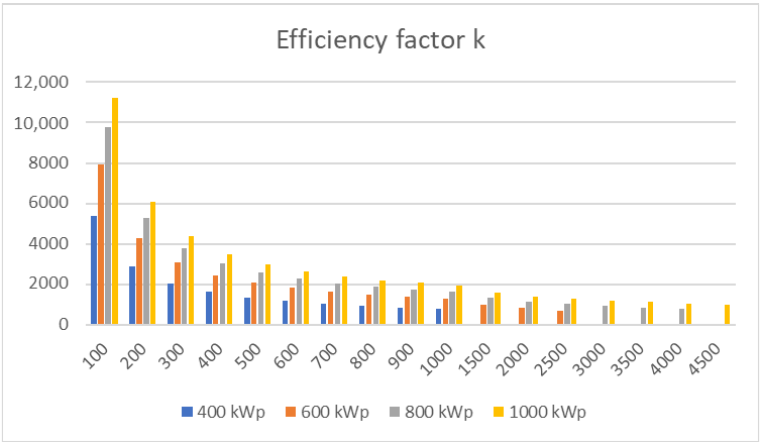
Figure 7. Energy use k coefficient values (see Equation (1)) for various FV installation powers and energy storage battery energy capacity from 100 to 4500 kWh.